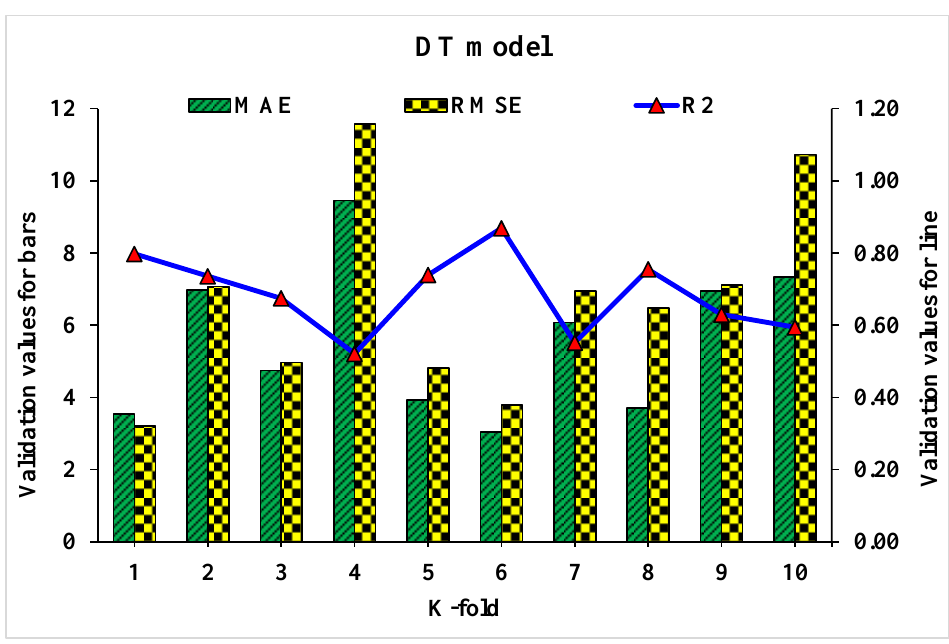
Figure 18. Statistical analysis of DT model for K-fold cross-validation.